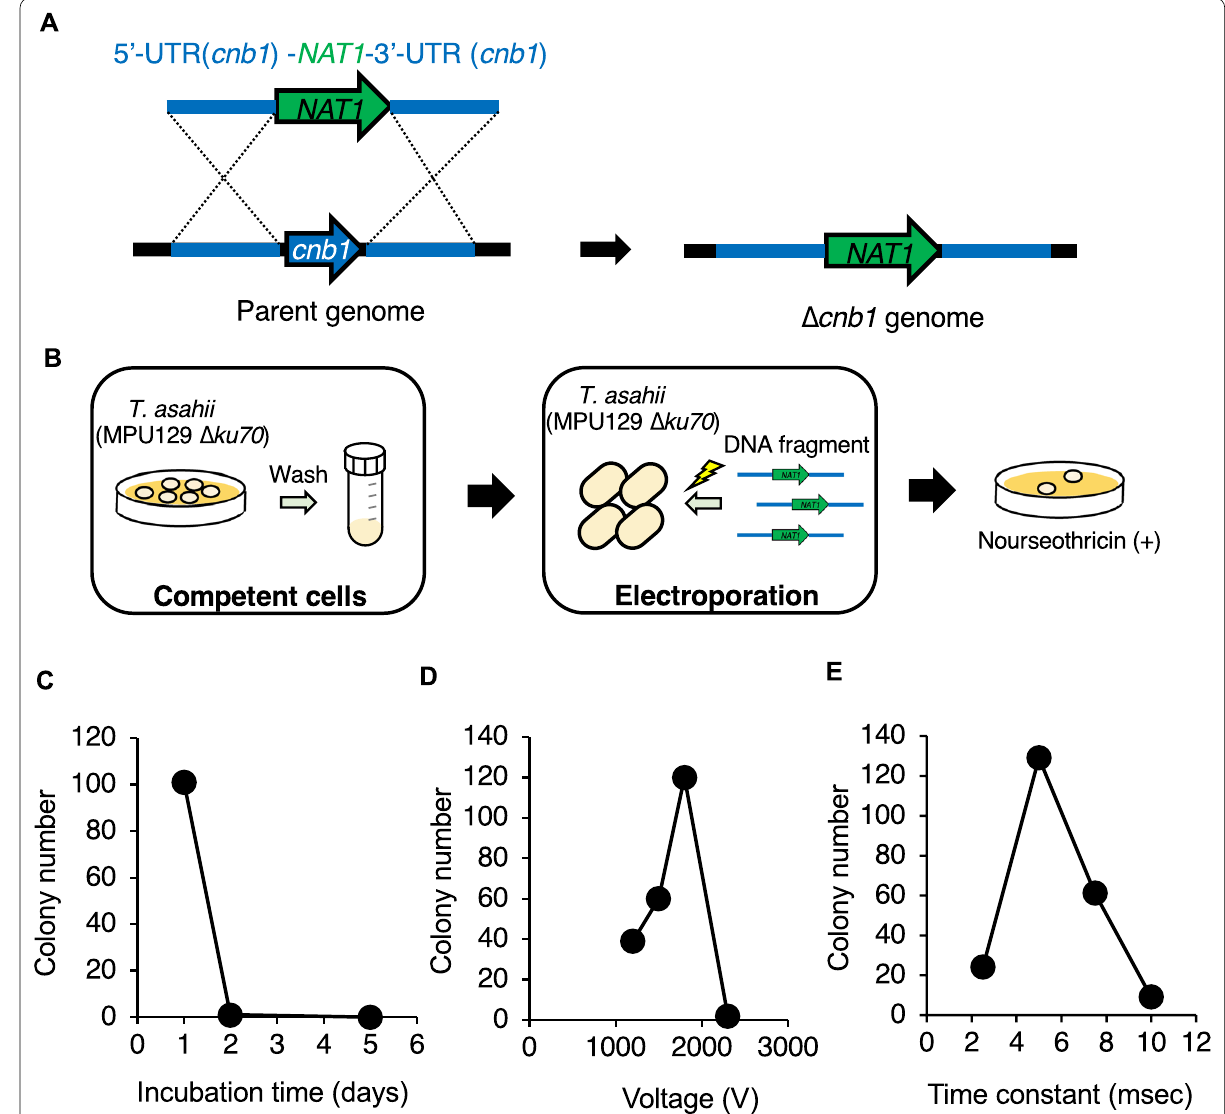
Fig. 1 Optimization of the conditions for gene transfer by electroporation in T. asahii . A Structure of the DNA fragment for constructing the cnb1 gene-deficient mutant and the predicted genome of the cnb1 gene-deficient mutant. B Scheme for obtaining drug-resistant strains by gene transfer via electroporation. C Effect of the number of incubation days for preparing competent T. asahii cells. The T. asahii MPU129 ku70 gene-deficient mutant was spread on SDA and incubated at 27 °C for 1, 2, or 5 days. The PCR-amplified 5’-UTR ( cnb1 ) - NAT1 -3’-UTR ( cnb1 ) fragment (180 ng/2 µl) was added to the competent T. asahii cells (40 µl) and electroporated (time constant protocol: 1.8 kV, 5 ms). The number of colonies grown on SDA containing nourseothricin (300 µg/ml) was counted. D Effect of voltage on gene transfer by electroporation. The PCR-amplified 5’-UTR ( cnb1 ) - NAT1 -3’-UTR ( cnb1 ) fragment (180 ng/2 µl) was added to competent T. asahii cells (40 µl) prepared by culture for 1 day